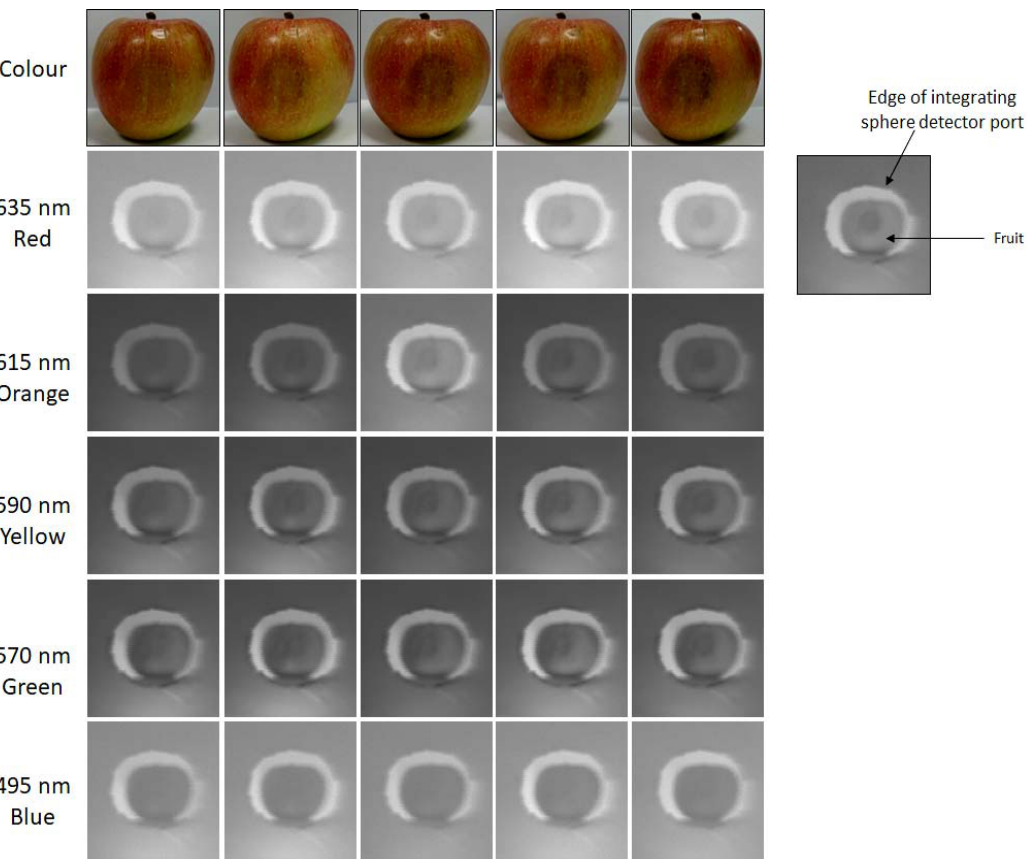
Figure 6. Bruise development over the measurement period: comparison between colour and hyperspectral datasets captured with a 128 × 128 pixel scene at 15 ms exposure per pixel. Note the varying levels of detection at different wavelengths.